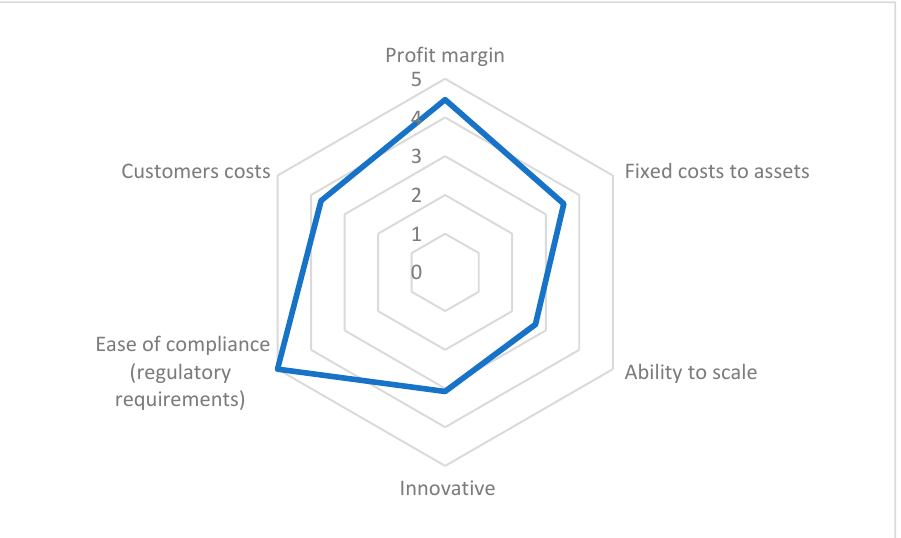
Figure 4. Responses to the request to evaluate the FinTech company against competitors; 1 = low, 7 = high (means).